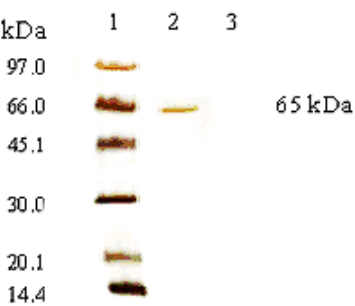
Table 3. Parameters used to calculate lipase hydrodynamic diameter at the interface.